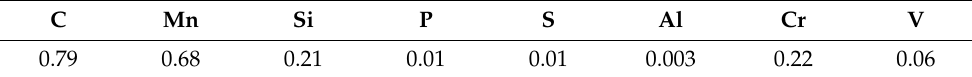
Table 1. Chemical composition (wt.%) of steels of family E (the balance is